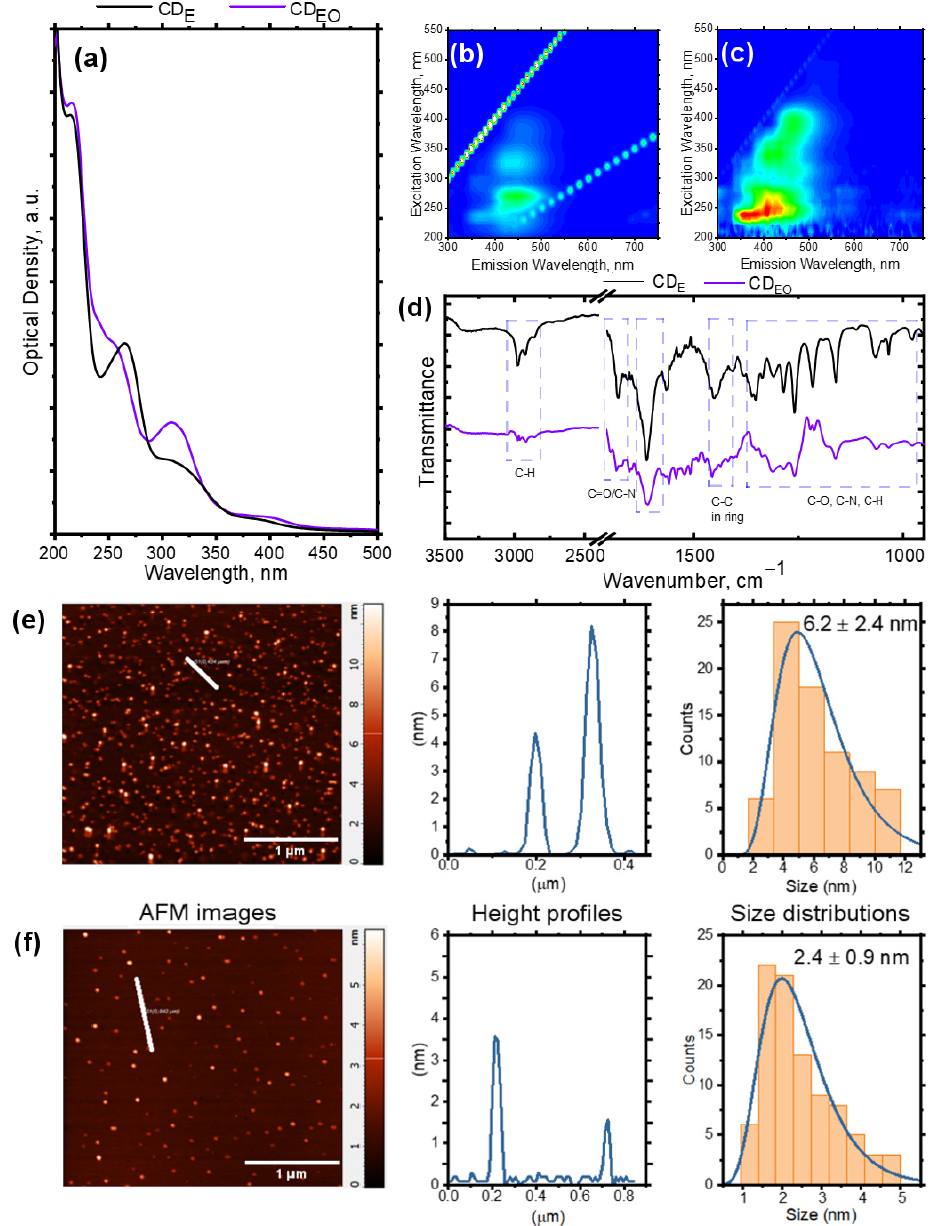
Figure 2. CDs characterization. ( a ) Absorption spectra of CD E (black line) and CD EO (violet line). PL excitation-emission maps for ( b ) CD E and ( c ) CD EO . ( d ) FTIR spectra of CD E (black line) and CD EO (violet line). ( e ) AFM image, height pro fi le, and size distribution for CD E . ( f ) AFM image, height pro fi le, and size distribution for CD EO .